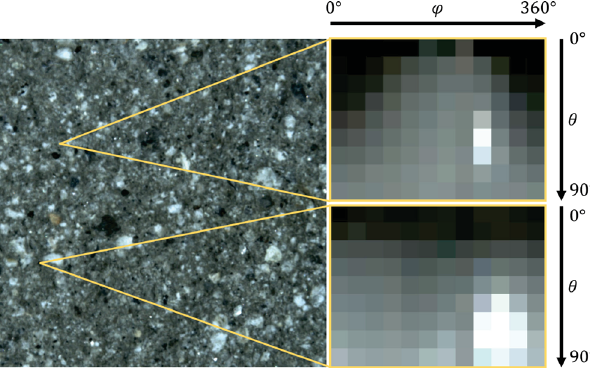
Fig. 14 Reflectance functions for single pixels. Left: image captured at ϕ = 90 ◦ ,θ = 79 ◦ . Right: corresponding reflectance functions for the two highlighted pixels.